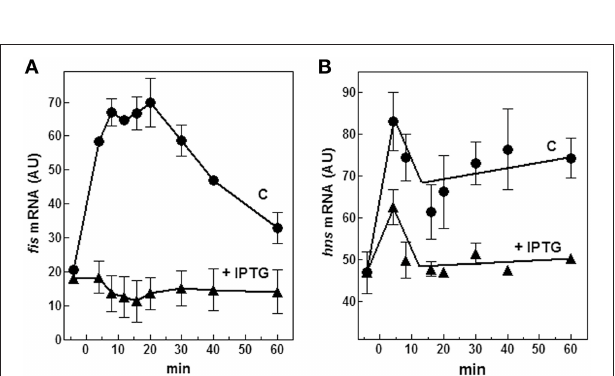
FIGURE 7 | Effect of (p)ppGpp on fis and hns expression. Levels of fis (A) and hns (B) mRNAs were estimated by Northern blotting analysis of total RNA extracted from E. coli cells growing at 37 ◦ C and carrying the plasmid pTK31. Cells were collected in stationary phase (time zero) and at the indicated times after dilution with fresh medium. As described in Figure 6A , the control culture was grown in the absence of IPTG ( N ) whereas the induced culture contained 400 µ M IPTG ( (cid:8) ) to activate the lacUV5::relA gene. Data represent the average of at least two independent experiments and standard deviation is